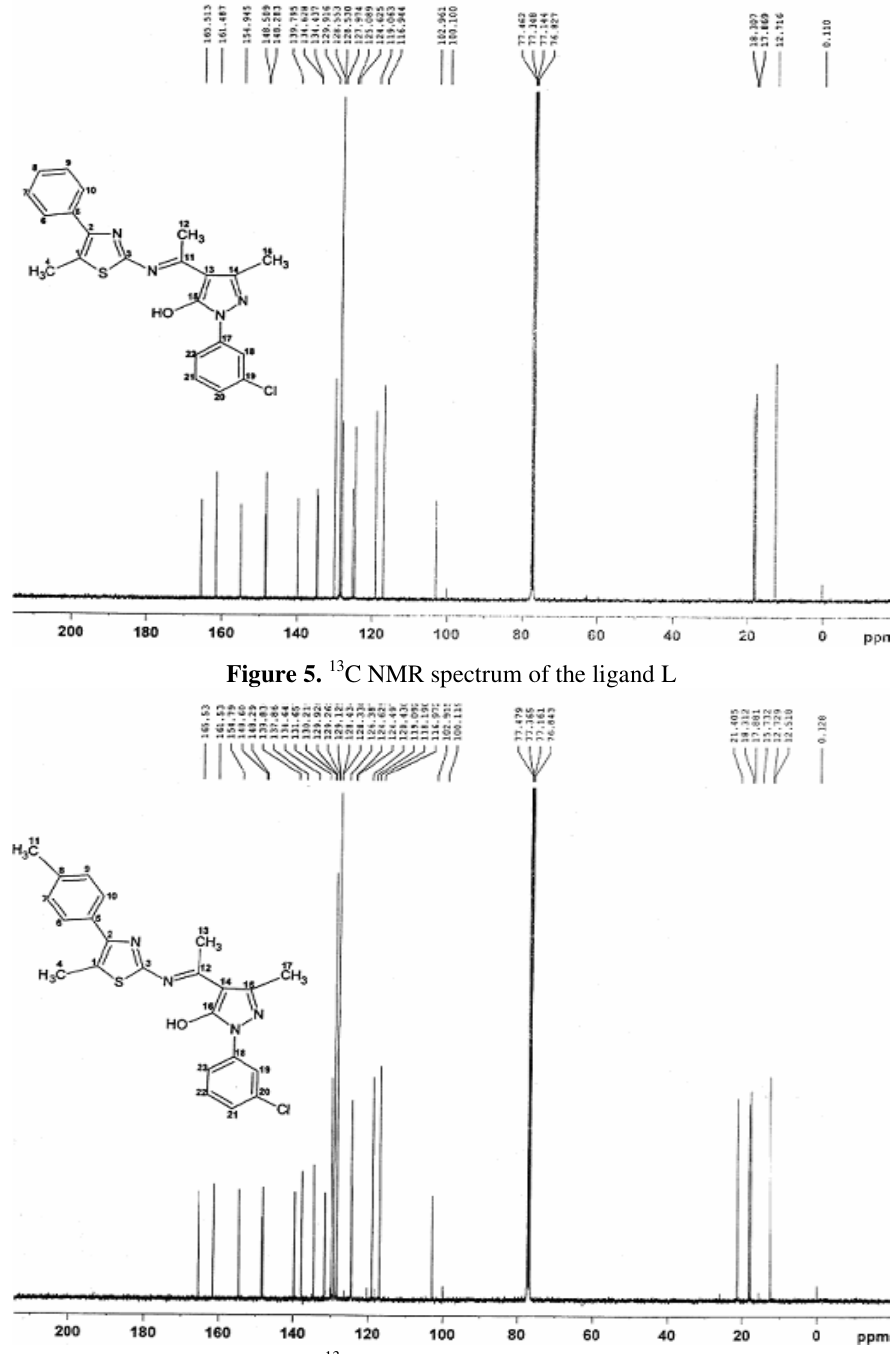
Figure 6. 13 C NMR spectrum of the ligand L